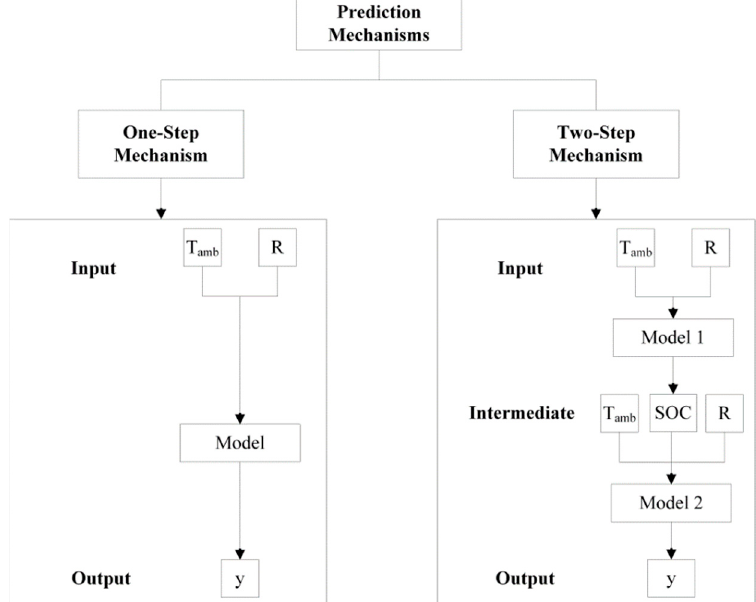
Figure 8. Machine learning methods used in the study.